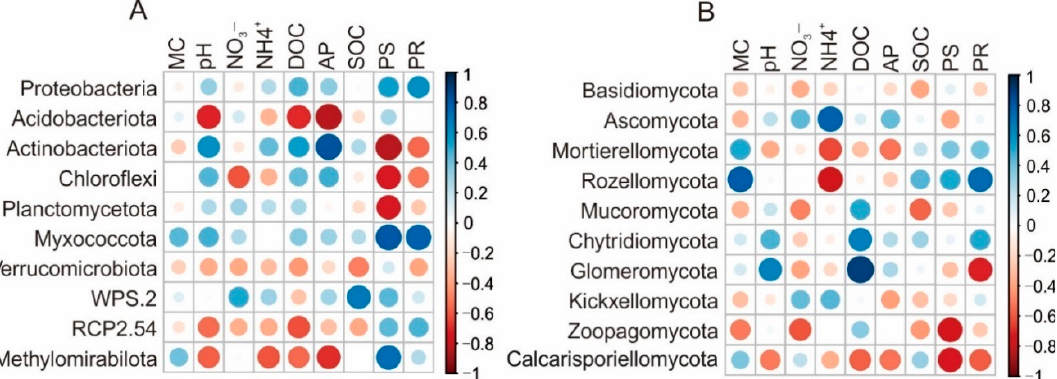
Figure 5. Pearson’s correlations between the top 10 bacterial ( A ) and fungal ( B ) phyla and environ- mental factors of the study area of Wuyi Mountain. MC, soil moisture content; pH, soil pH; NO 3 − , nitrate nitrogen; NH 4+ , ammonia nitrogen; DOC, dissolved organic carbon; AP, available phosphorus; SOC, soil organic carbon; PR, plant richness; PS, plant Shannon diversity.